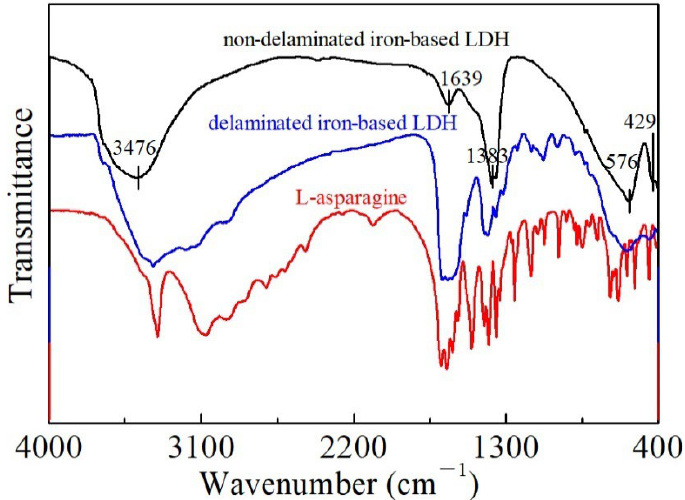
Figure 4. FT-IR spectra of the non-delaminated and delaminated iron-based LDH samples.